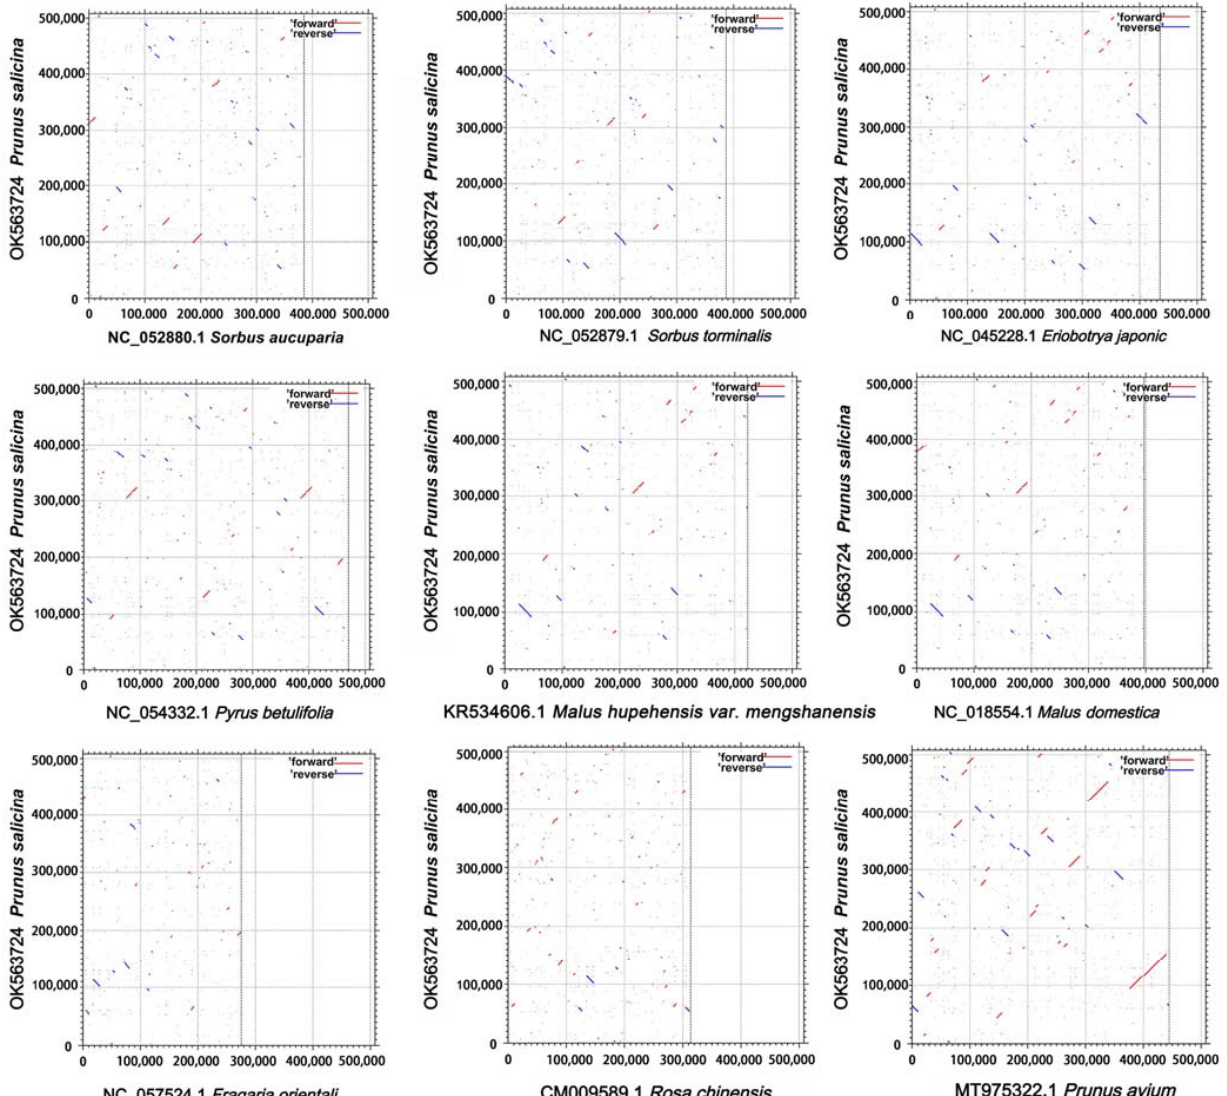
Figure 2. Dot-plot graphs indicating regions of synteny between mitochondrial genomes in Rosaceae compared to P. salicina as the reference.